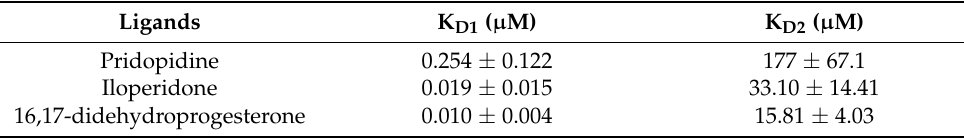
Table 6. Dissociation constant (K D ) values determined by fluorescence